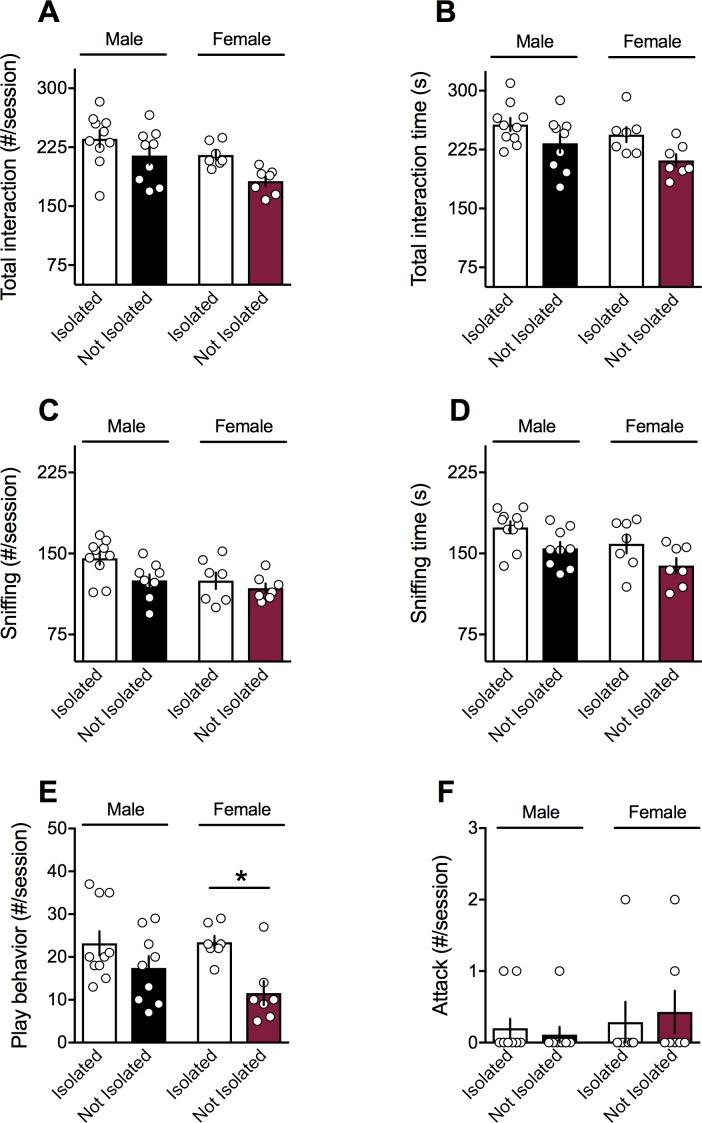
Social isolation before testing did not induce sex-specific social changes in adult animals.(A-B) Adult male and female naïve animals not isolated 24 hr before testing showed no difference in contact (A): F(sex x isolation)1,29=0.203, p>0.05, two-way ANOVA) and time to interact with their congeners than male and female SHAM-animals isolated before testing (B): F(sex x isolation)1,29=0.372, p>0.05, two-way ANOVA). During the social session, the number (C): F(sex x isolation)1,29=0.003, p>0.05, two-way ANOVA) and the time (D): F(sex x isolation)1,28=1.253, p>0.05, two-way ANOVA) of sniffing events were unchanged; the frequency of play behavior (E): F(sex x isolation)1,29=1.289, p>0.05, two-way ANOVA) were exclusively reduced in female naïve rats not isolated before testing. Social isolation did not change aggressive behavior in adult naïve rats (F): F(sex x isolation)1,29=0.325, p>0.05, two-way ANOVA). Scatter dot plot represents a pair of animals. Error bars indicate SEM. *p<0.05. Student–Newman–Keuls test.